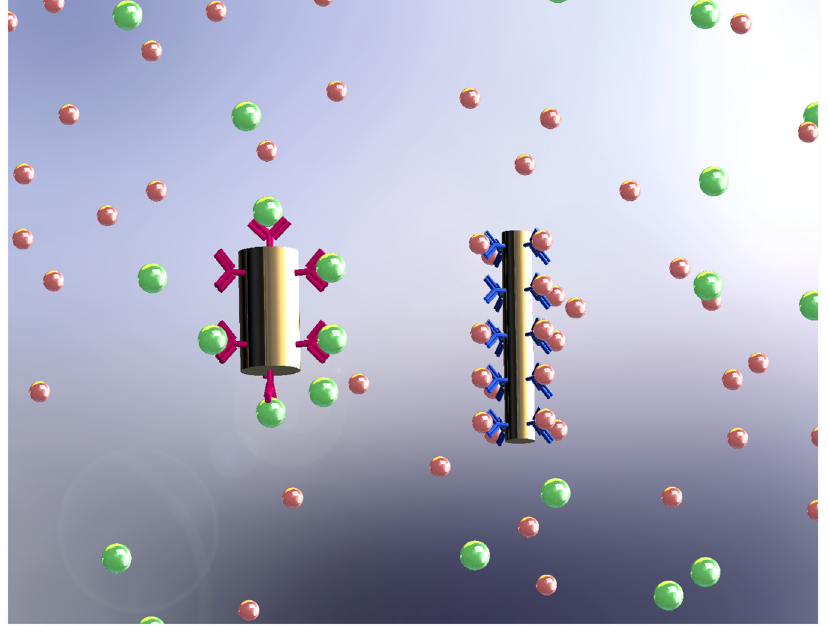
Fig 1. Two different nanorods functionalized with different receptors. Neurotransmitters selectively bind to the associated nanorods. Figure is drawn by E.F.